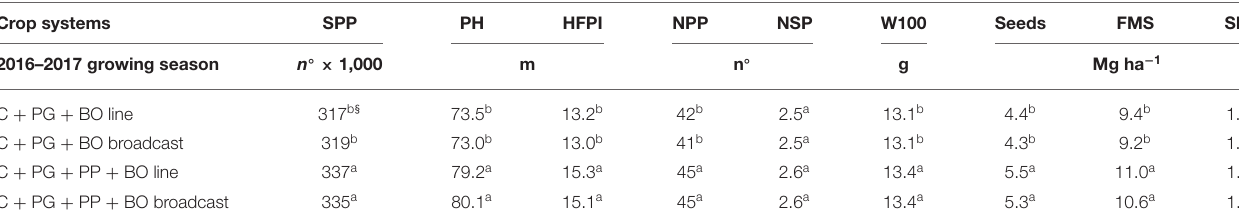
TABLE 11 | Soybean plant population (SPP), plant height (PH), height of the first pod insertion (HFPI), number of pods per plant (NPP), number of seeds per pod (NSP), dry weight of 100 seeds (W100), dry weight of seeds per hectare, forage mass (FM), and standing plant residue (SPR) on the soil surface of soybean to silage intercropped with guinea grass in the fourth growing season in succession with corn to silage intercropped with palisade grass (C + PG) and with palisade grass and pigeon pea (C + PG + PP) with black oat (BO) oversown in lines and broadcast in the first three growing seasons. Crop